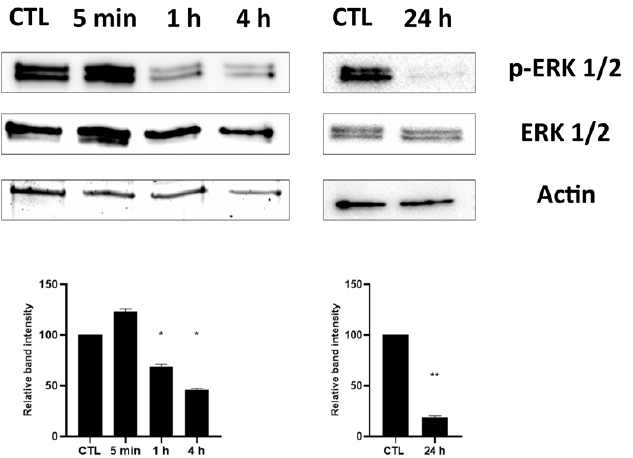
Figure 4. Effects of HPE DMSO on ERK phosphorylation. Cells were left untreated (CTL) or treated with 0.1 mg/mL of HPE DMSO . Cell extracts were analyzed at 5 min, 1 h, 4 h and 24 h after treatment by western blot, using anti-ERK/ p -ERK and actin antibodies (upper side). The densitometric analysis (bottom side) was performed by ImageJ. Results are expressed as mean ± SEM of data obtained by three independent experiments. * p < 0.05; ** p < 0.01 vs. CTL.